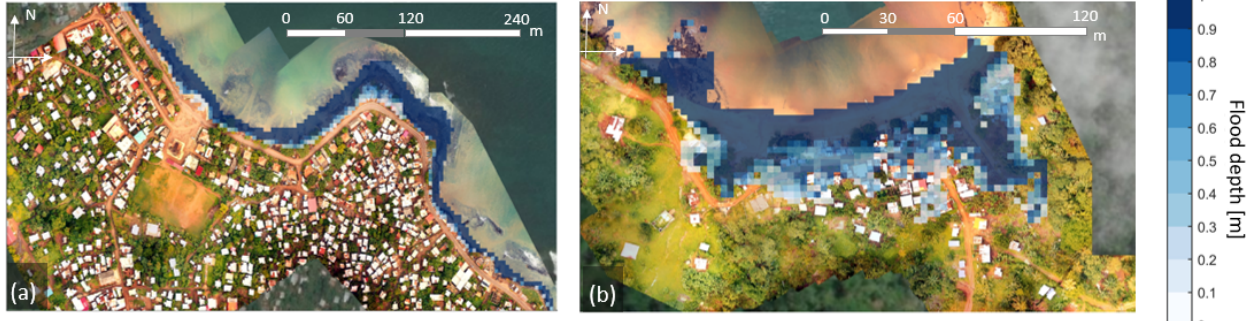
Figure 6. Flood depth map estimated by SFINCS for the baseline scenario for Pantufo (a) and Praia Abade (b) . Flood depths are expressed in metres. Both aerial images were reproduced with permission from CDR International.